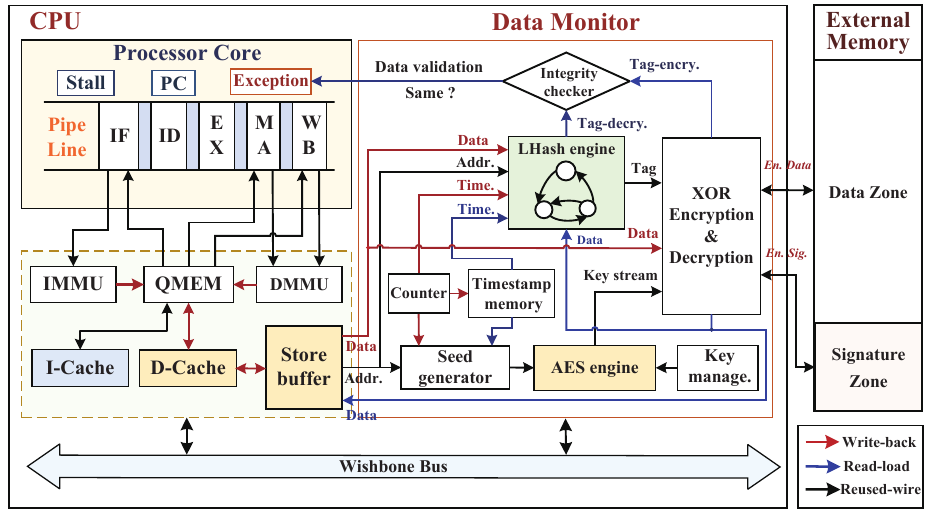
Figure 8. The hardware implementation of the data monitor connected with the